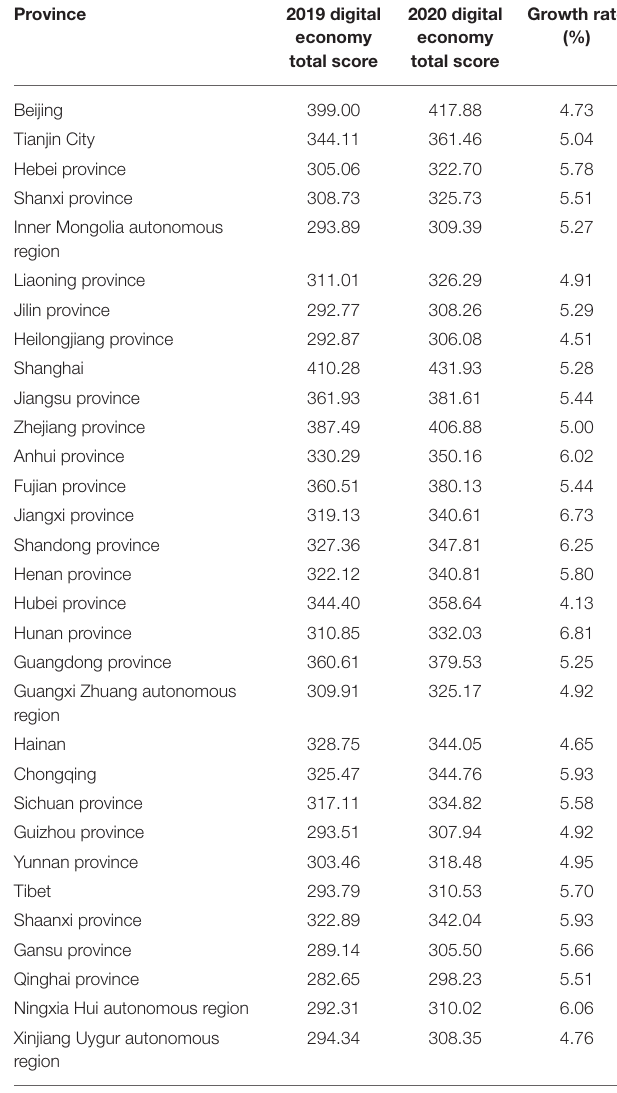
TABLE 2 | Results of the entropy